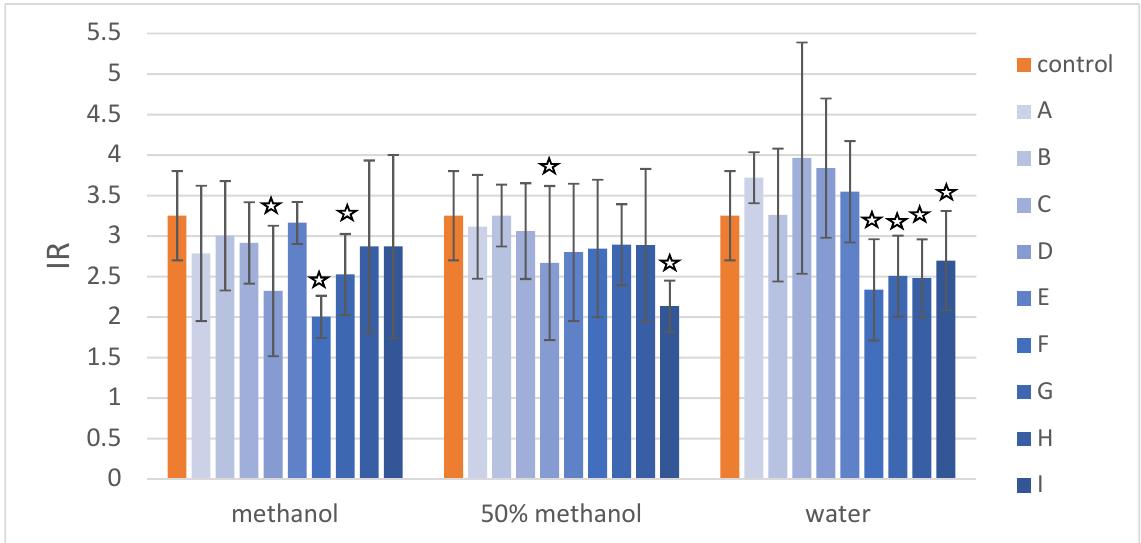
Figure 10. The results of the evaluation of antigenotoxic activity based on IR values for the control— genotoxin 2-aminoanthracene (2AA 10 µg/mL)—and the mixture of 2AA with extracts (100 µg/mL) dissolved in methanol, 50% methanol, or deionized water. The asterisks highlights the statistically significant ( p < 0.05) differences in the cells viability compared with the control. The extracts resulted from the following treatments were investigated: ( A ) control roots collected after 10 days of culture;